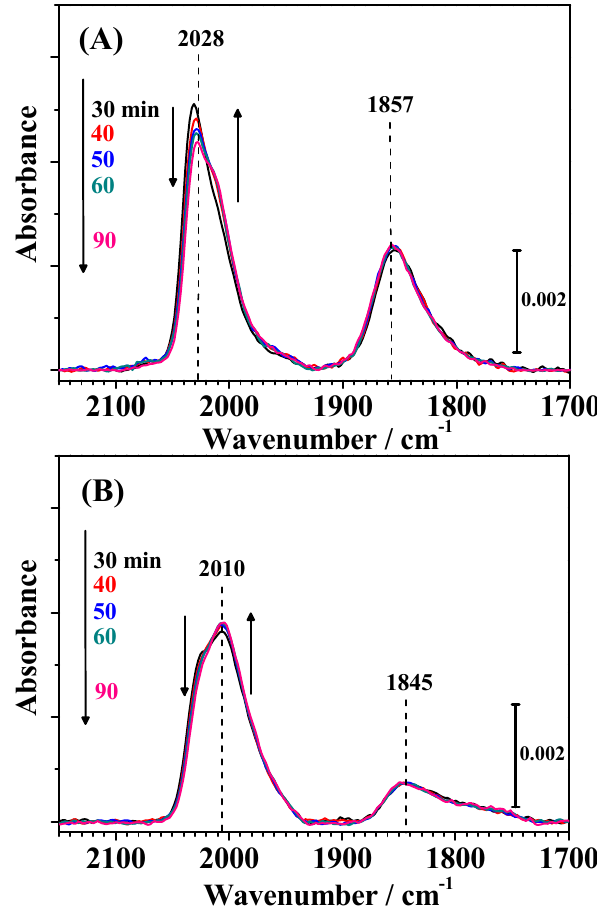
Figure 6. Changes in FTIR spectra observed on CO ‐ adsorbed electrodes of ( A ) Pt 2AL –PtFe/C and ( B ) c ‐ Pt 2 Ru 3 /C at 0.02 V and 60 °C in 0.1 M HClO 4 during a recovery process of HOR by bubbling CO ‐ free pure H 2 for 60 min (see Figure 7 below). CO was pre ‐ adsorbed by bubbling 1% CO/H 2 for 30 min, and time intervals shown in ( A ) and ( B ) correspond to those from 30 min, at which time the gas was changed from 1% CO/H 2 to pure H 2 .